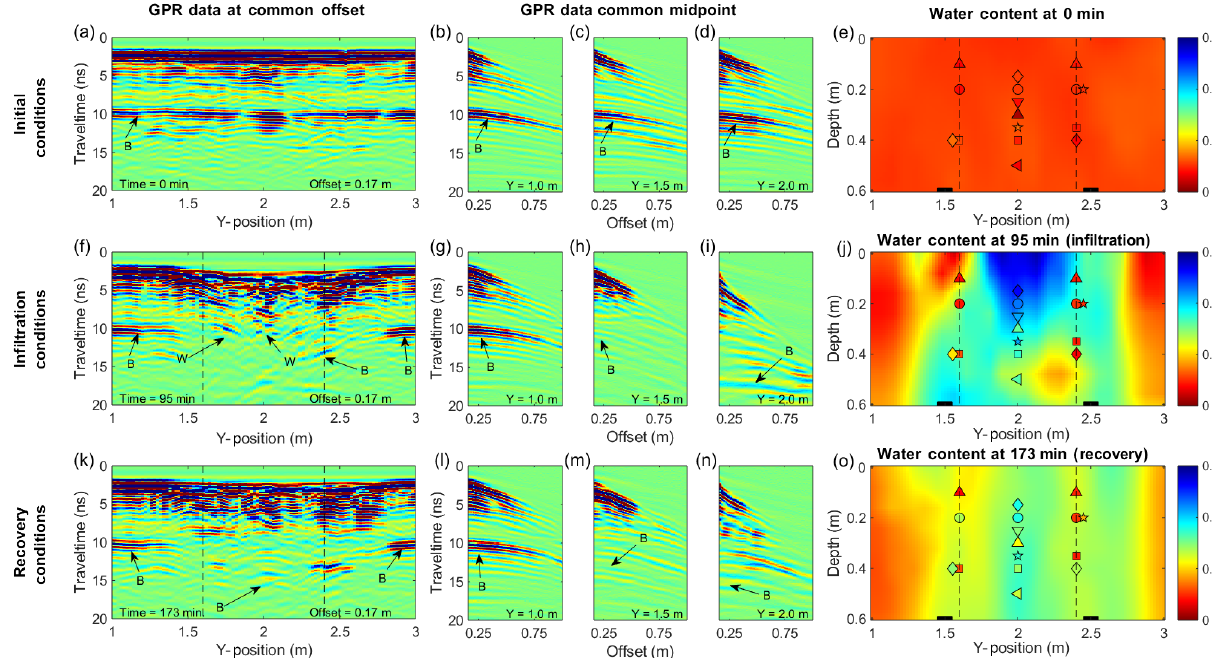
Figure 4. Panels (a, f, k) are common-offset GPR data collected during the experiment. Panels ( b–d , g–i , and l–n ) are CMP data collected during the experiment. Arrivals annotated are the sand layer reflection ( B ) and wetting front reflection ( W ). Panels (e, j, o) show tomography results for the corresponding GPR data. Vertical lines indicate the lateral extent of the wetted surface. Shapes correspond to the soil moisture data for the given y location in Fig. 5 and colors correspond to the measured soil moisture. Adjacent symbols are from probes that are located at different x locations but identical